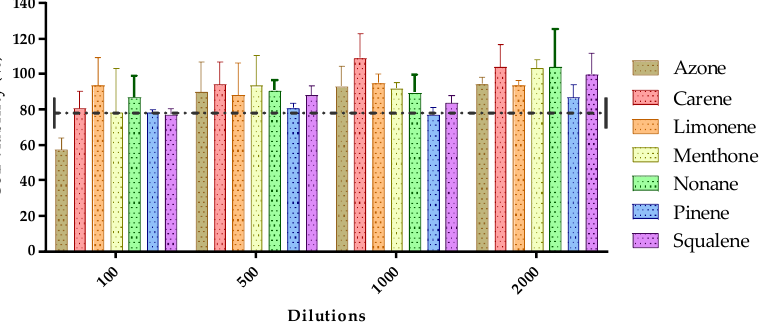
Figure 4. Effect of permeation promoters at different dilutions on the viability of HaCaT keratinocyte cells in vitro.